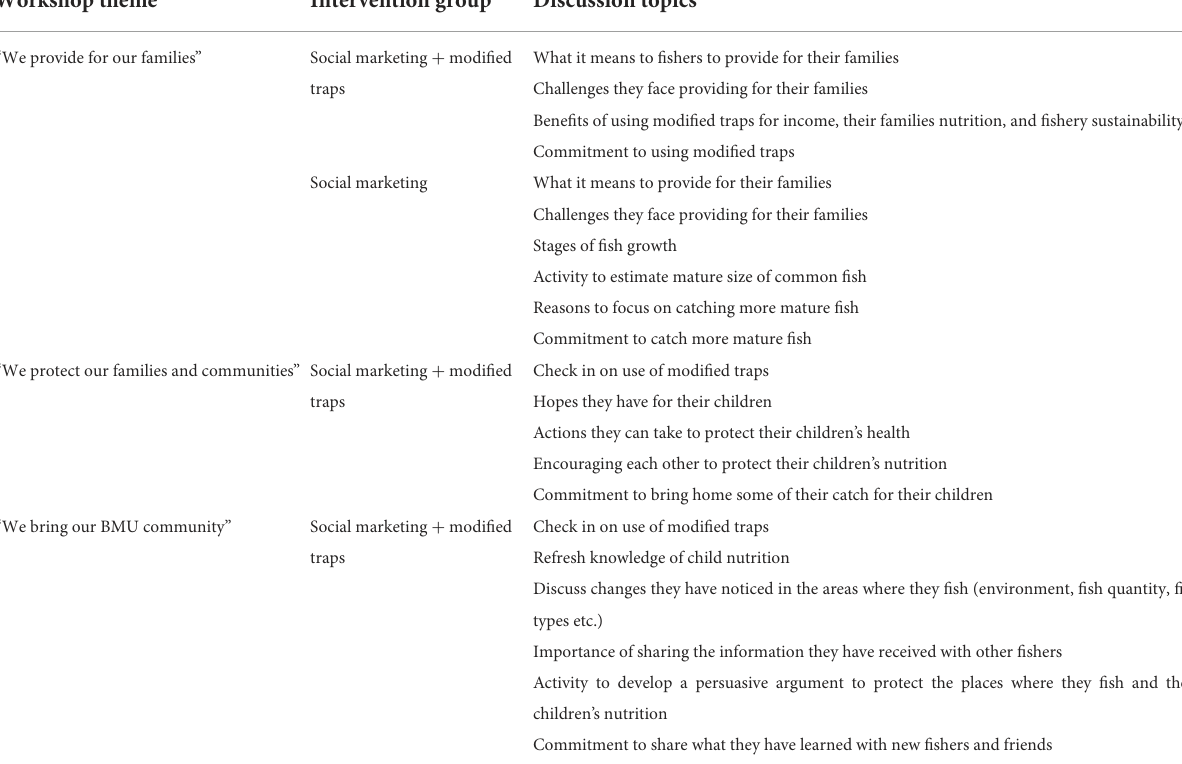
TABLE 4 Themes and topics of fisher